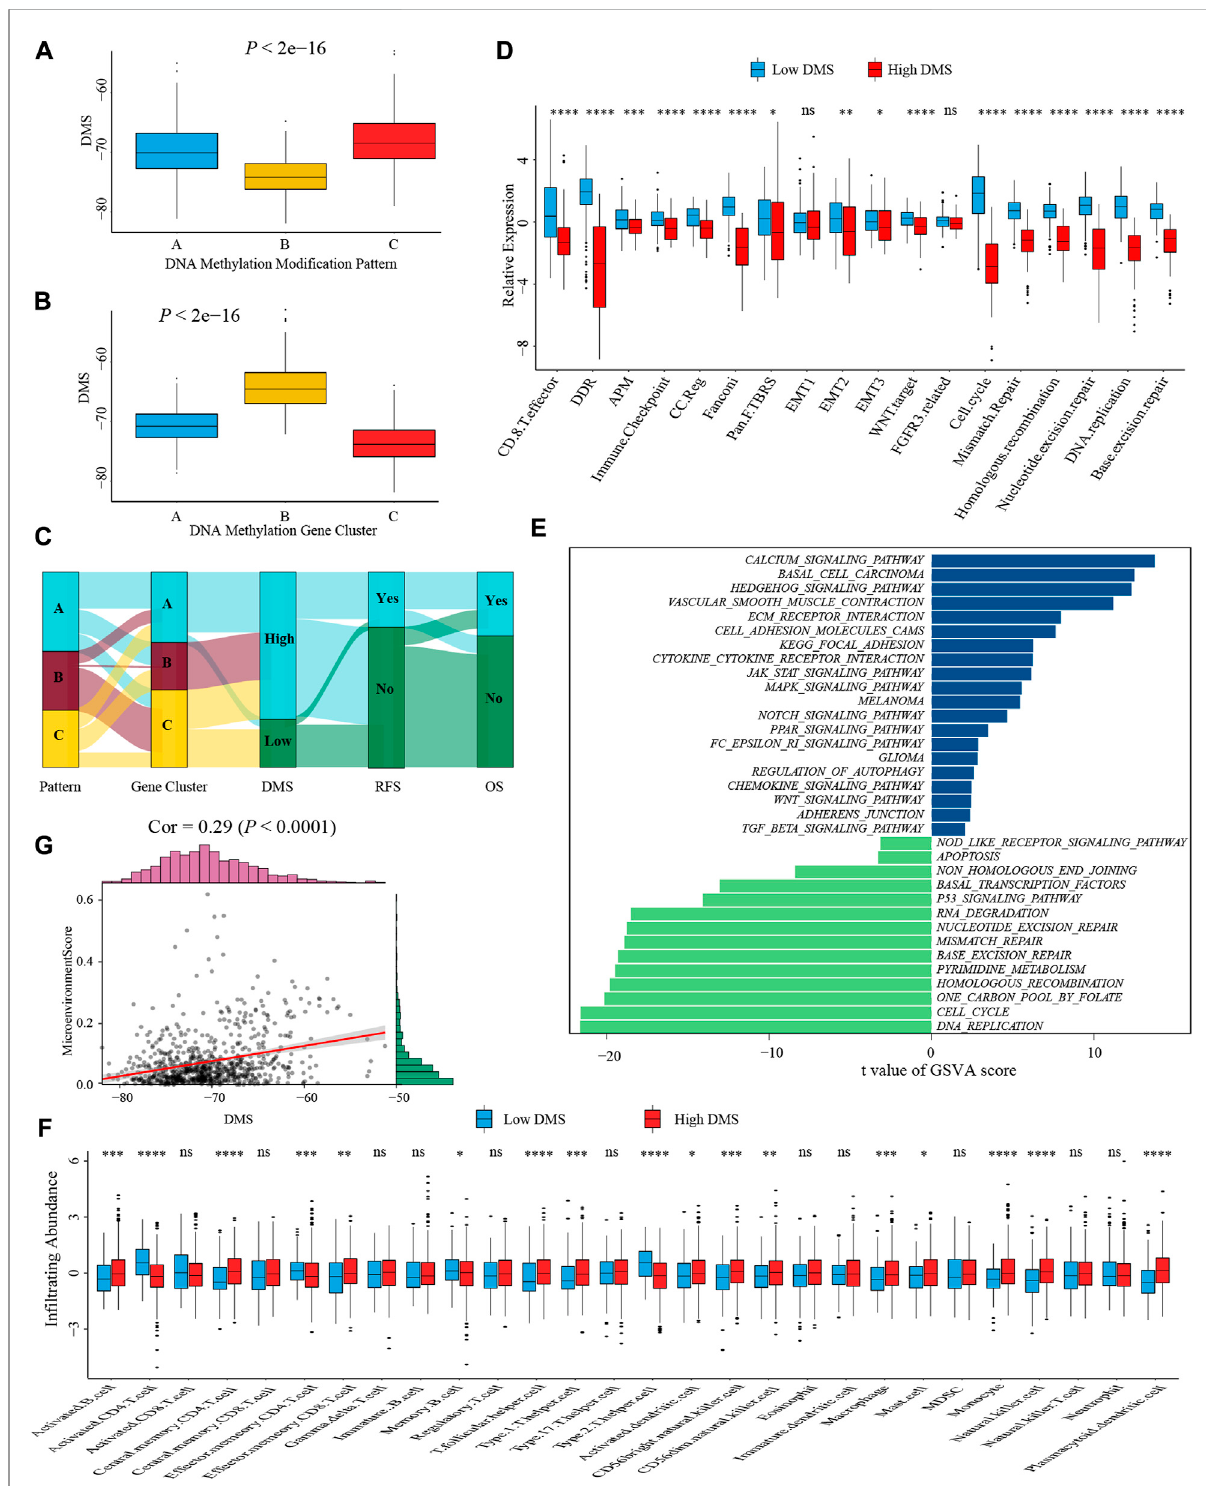
Characterization of DMS in TME and biological processes. (A) Differences in DMS among three DNA methylation modi fi cation patterns in the meta-cohort (Kruskal-Wallis test; p < 0.001). (B) Differences in DMS among three DNA methylation gene clusters in the meta-cohort (Kruskal-Wallis test; p < 0.001). (C) Sankey diagramvisualizedthedistributionofindividual colon cancerpatients indifferentDNAmethylationmodi fi cationpatterns, gene clusters, DMS, and clinical outcomes. (D) The differences in biological processes signatures between DMS-high and -low